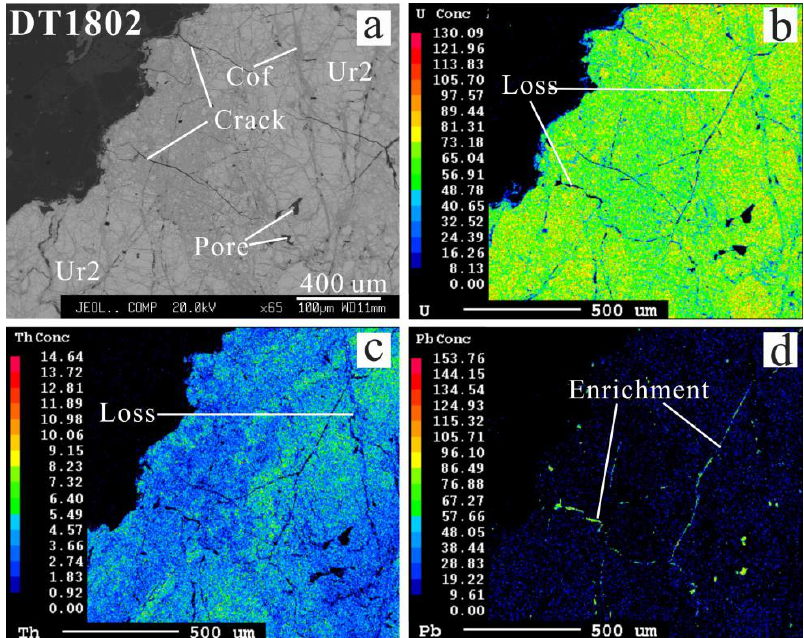
Figure 8. ( a ) BSE images and ( b – d ) X-ray element maps of the Ur2 uraninite grains showing intra- grain compositional heterogeneity. ( b – d ) The element maps show that the fractures and pores in the uraninite grain are depleted in U and Th and enriched in Pb. Mineral abbreviations: Ur — uraninite; Cof — coffinite.